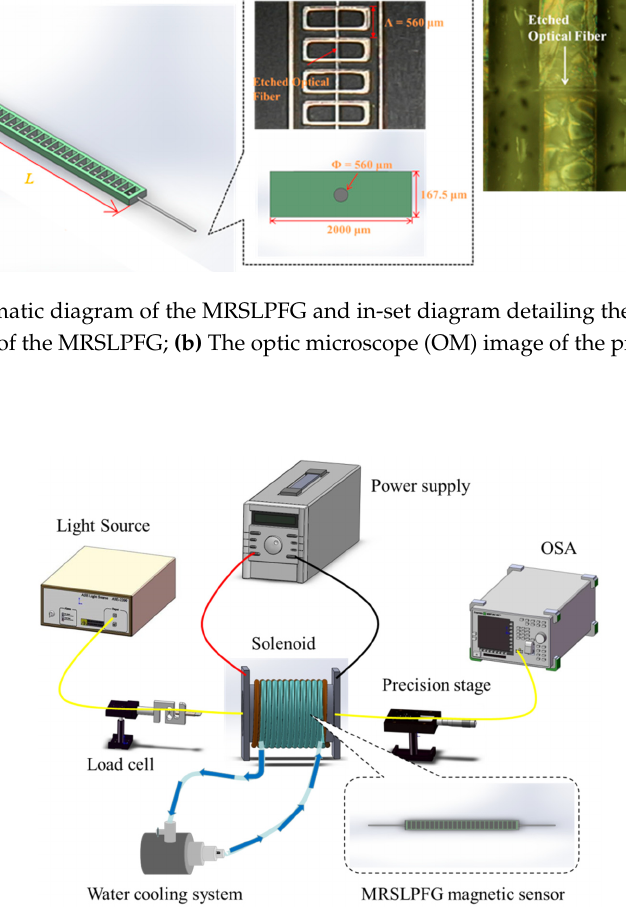
Figure 4. The schematic diagram of experimental setup for the micro rectangular ‐ shaped long ‐ period fiber grating (MRSLPFG) magnetic sensor. fiber grating (MRSLPFG) magnetic